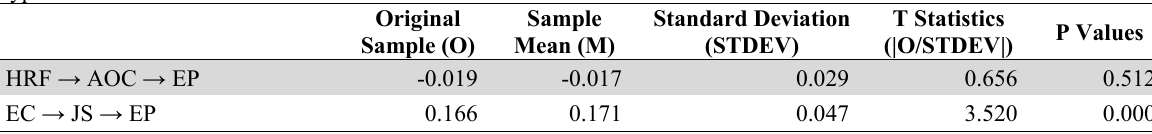
Hypothesis test results for indirect effect